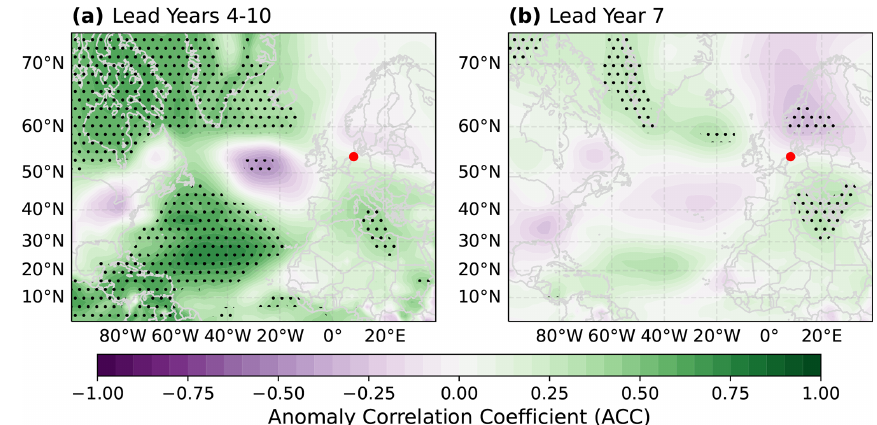
Figure 4. Grid-point-wise anomaly correlation coefficient (ACC) between the deterministic hindcast ensemble mean prediction of winter mean (DJF) MSLP anomalies and ERA5 reanalysis data for lead years 4–10 (a) and lead year 7 (b) . The German Bight is marked by a red dot. Anomalies are calculated for each member individually and averaged over the entire ensemble afterwards. Stippling indicates significant correlations ( p ≤ 0 .